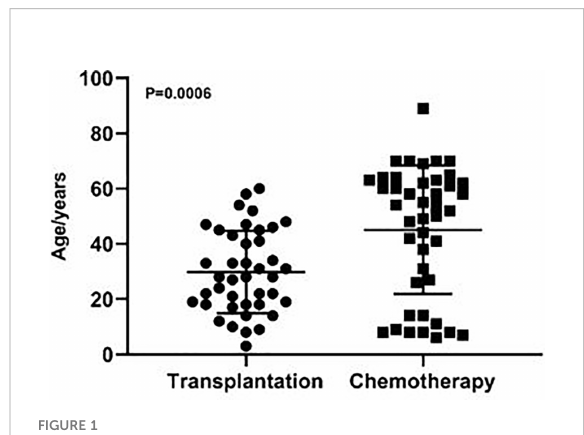
FIGURE 1 The age distribution of patients in the transplantation and chemotherapy groups. The patients in the transplant group were signi fi cantly younger than those in the chemotherapy group